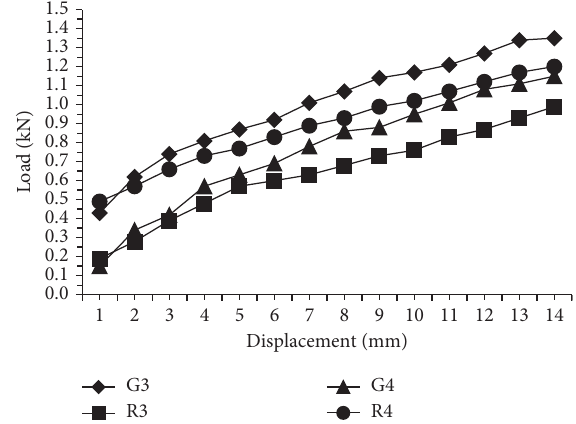
Figure 16: Displacement-load curves of the pile